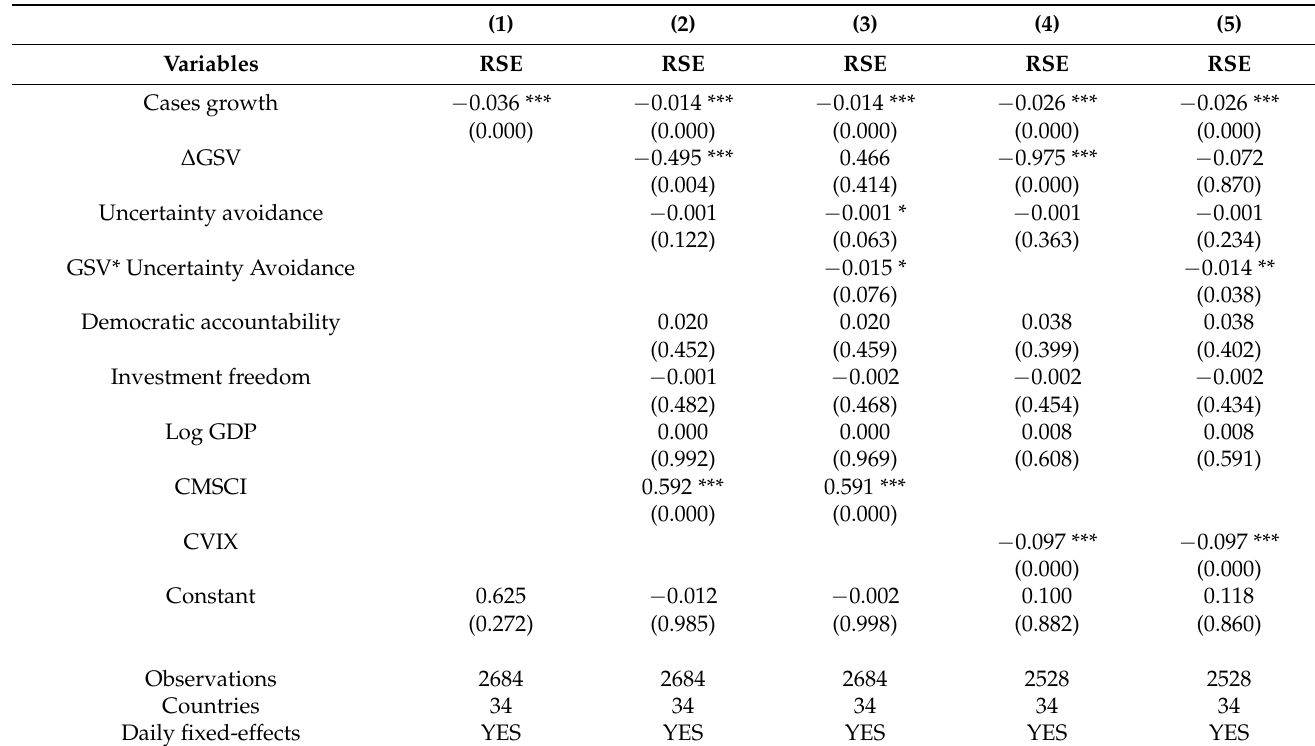
Table A4. Panel regression results: robustness tests with random-effects model.